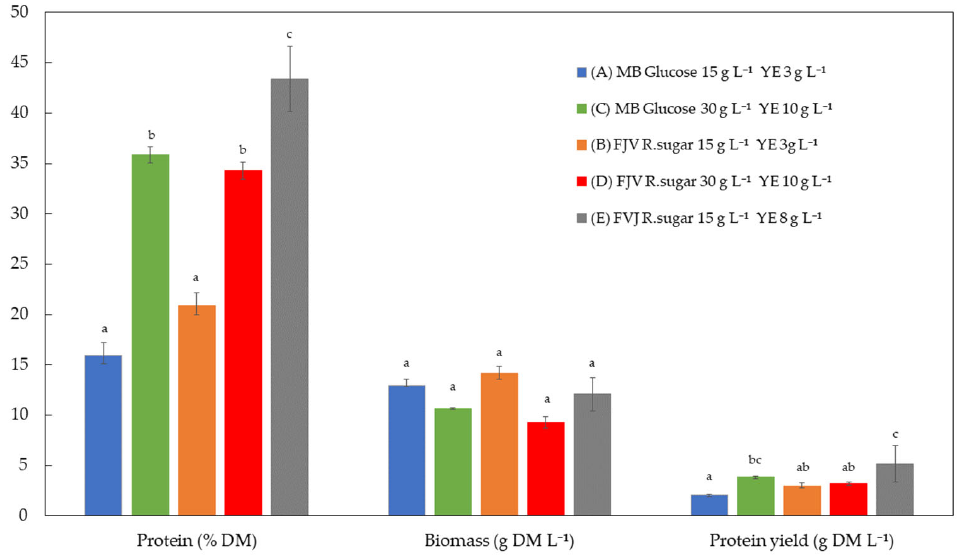
Figure 2. Protein (% DM), biomass (g DM L − 1 ) and protein yield (g DM L − 1 ) production in the five conditions studied in bottles. MB: modified Bristol; R.sugar: reducing sugar; FVJ: fruit and vegetable juices; YE: yeast extract; DM: dry matter. Error bars represent SD (n = 3). Same letter means no significant difference between samples at 95% con fi dence.